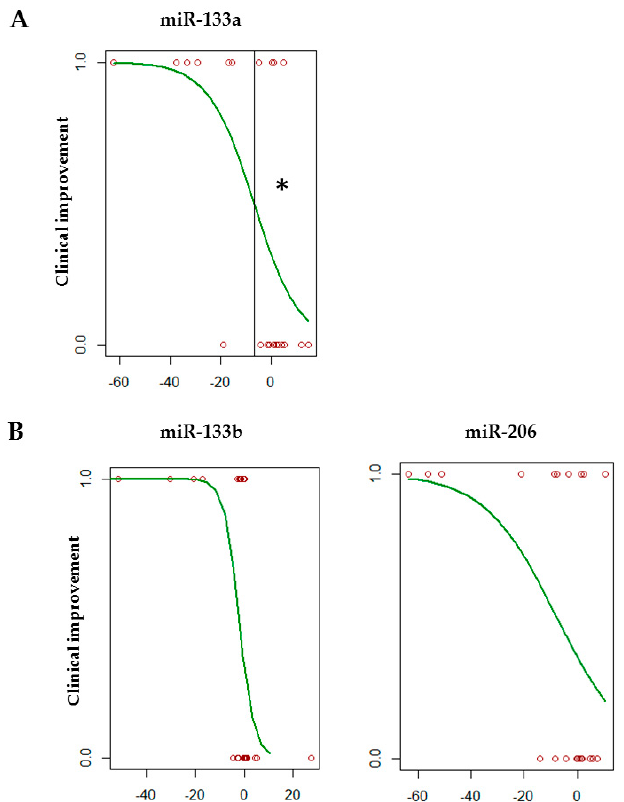
Figure 3. miR-133a reduction predicts clinical improvement of SMA patients during nusinersen treatment. Logistic regression analysis of miRNA differential expression and clinical response to therapy after 6 months of nusinersen treatment. Each circle represents miRNA expression level in serum of a patient after 6months of treatment. An improvement at the HFMSE score ≥ 3 was considered clinically meaningful (1.0 on y axis). A significant relationship for miR-133a reduction by 6.6 C t values (inflection point) ( A ), and a positive trend for miR-133b and -206 are reported ( B ). * p < 0.05.